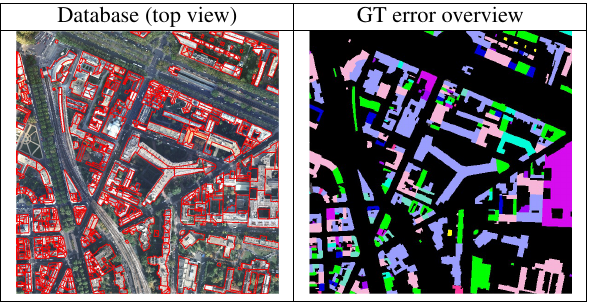
Figure 2: An overview of the Ground Truth (GT): a maximum of 4 labels per element. Correct n ; Erroneous outline n ; Unexisting building n ; Missing inner court n ; Inaccurate footprint n ; Under-segmentation n ; Over-segmentation n ; Roof inaccurate n ; Z translation n ; Vegetation n